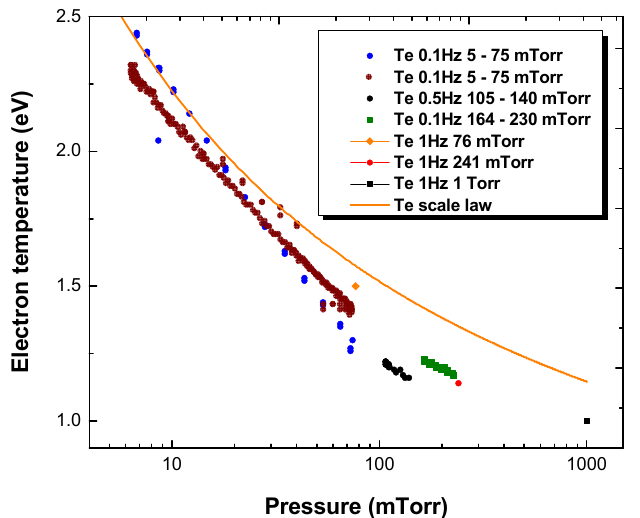
Figure 9. Evolution of the electron temperature with the pressure for the complete set of experimental conditions compared with a scale law (orange curve).